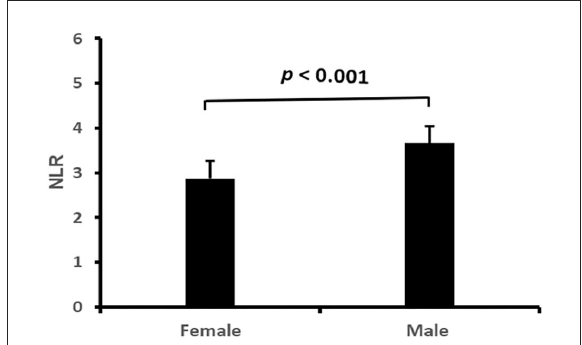
FIGURE2 The NLR in man and woman. NLR, neutrophil to lymphocyte ratio.